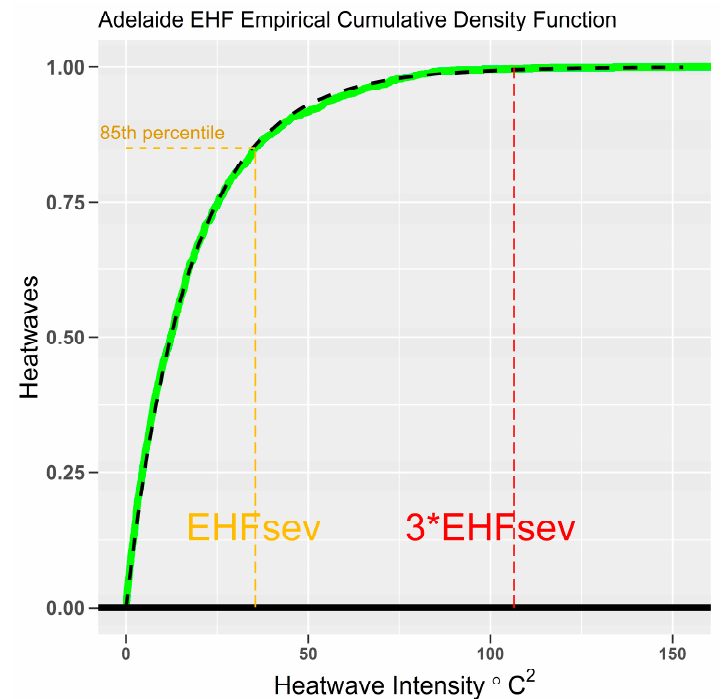
Figure A7. Adelaide empirical cumulative distribution of positive EHF (green line), overlain with the modelled generalized Pareto distribution (black dashes), and showing the 85th percentile (transition point) for determining the severe EHF threshold (dashed yellow lines). Extreme EHF threshold is shown in red (dashed red lines).